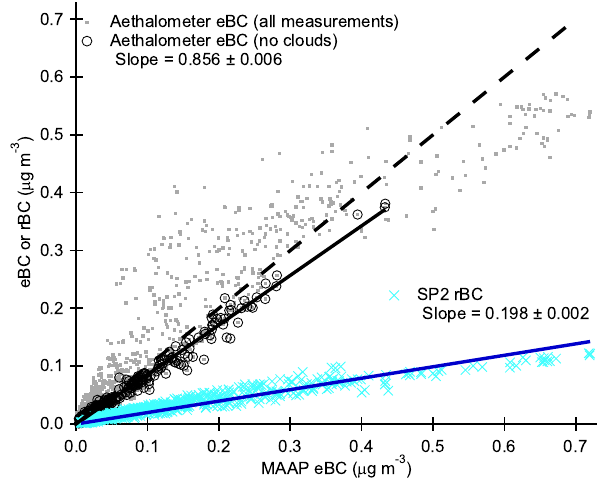
Figure 6. Aethalometer eBC (dots show all measurements and cir- cles are those where the station is not in cloud) and SP2 rBC (crosses) as a function of MAAP eBC as well as linear fits (fixed zero offsets) to the data points. The dashed line shows 1:1